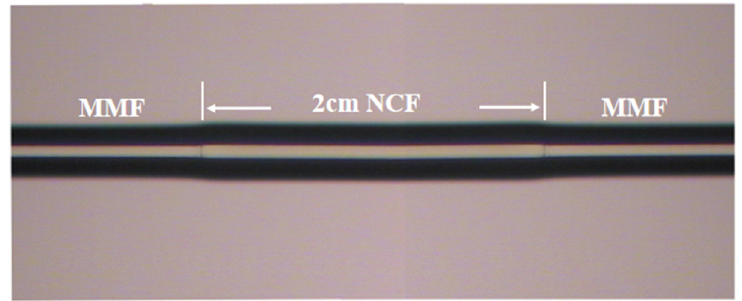
Figure 4. Microscopic image of the MMF-NCF-MMF.